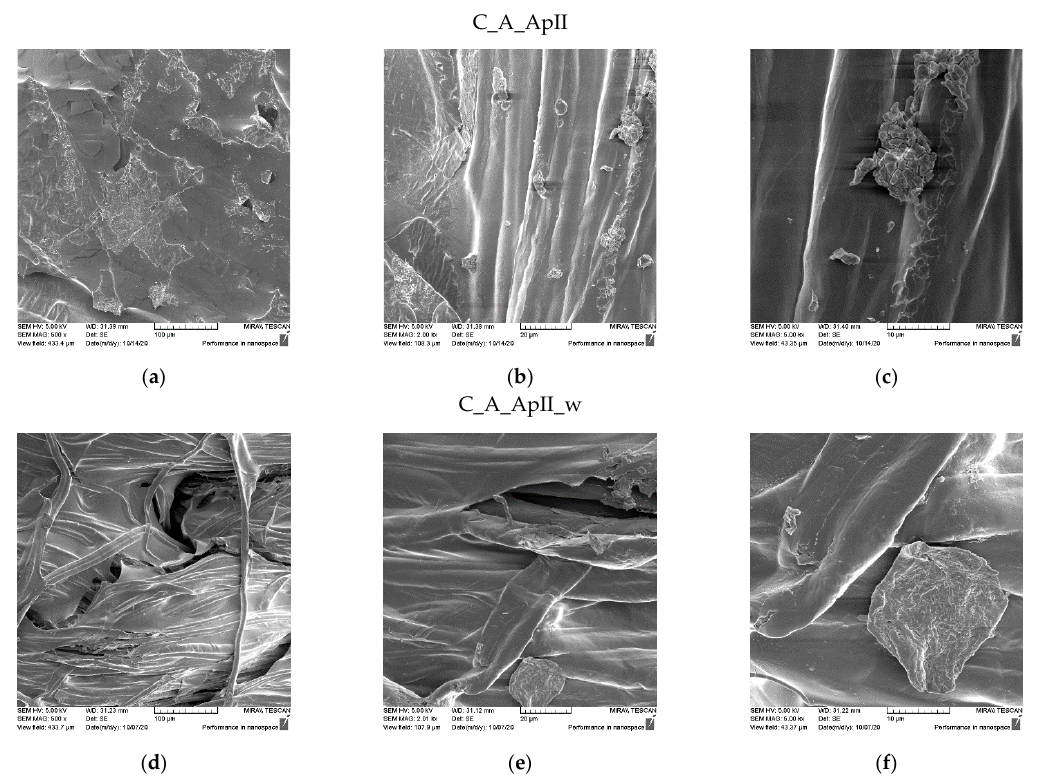
Figure 6. SEM micrographs of satin weave fabric samples treated with Bath II before (C_A_ApII) and after washing (C_A_ApII_w) at different magnifications: ( a , d ) 500x, ( b , e ) 2000x, and ( c , f ) 5000x.